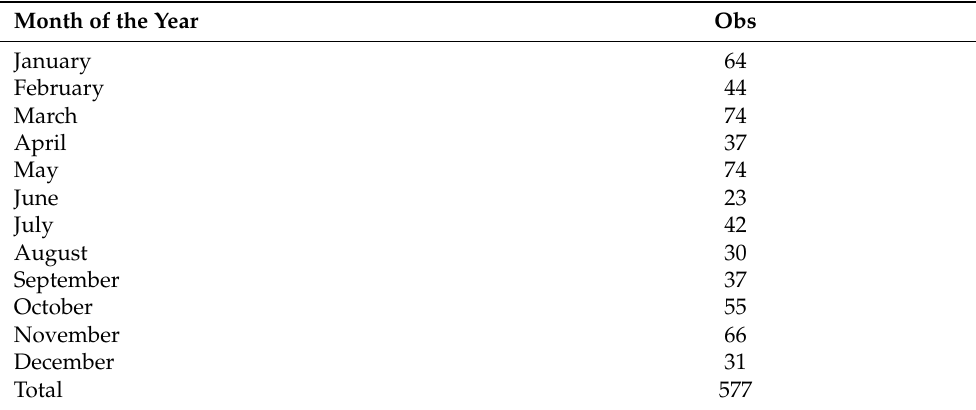
Table 1. Bulls evaluated per